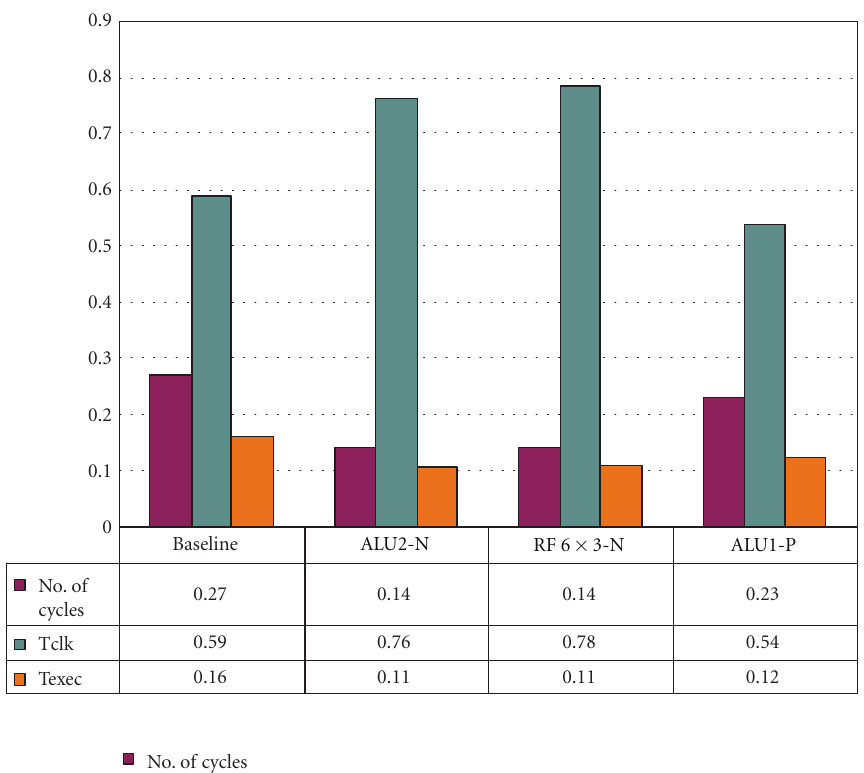
Figure 22: Performance comparison for Mp3 relative to implementation on